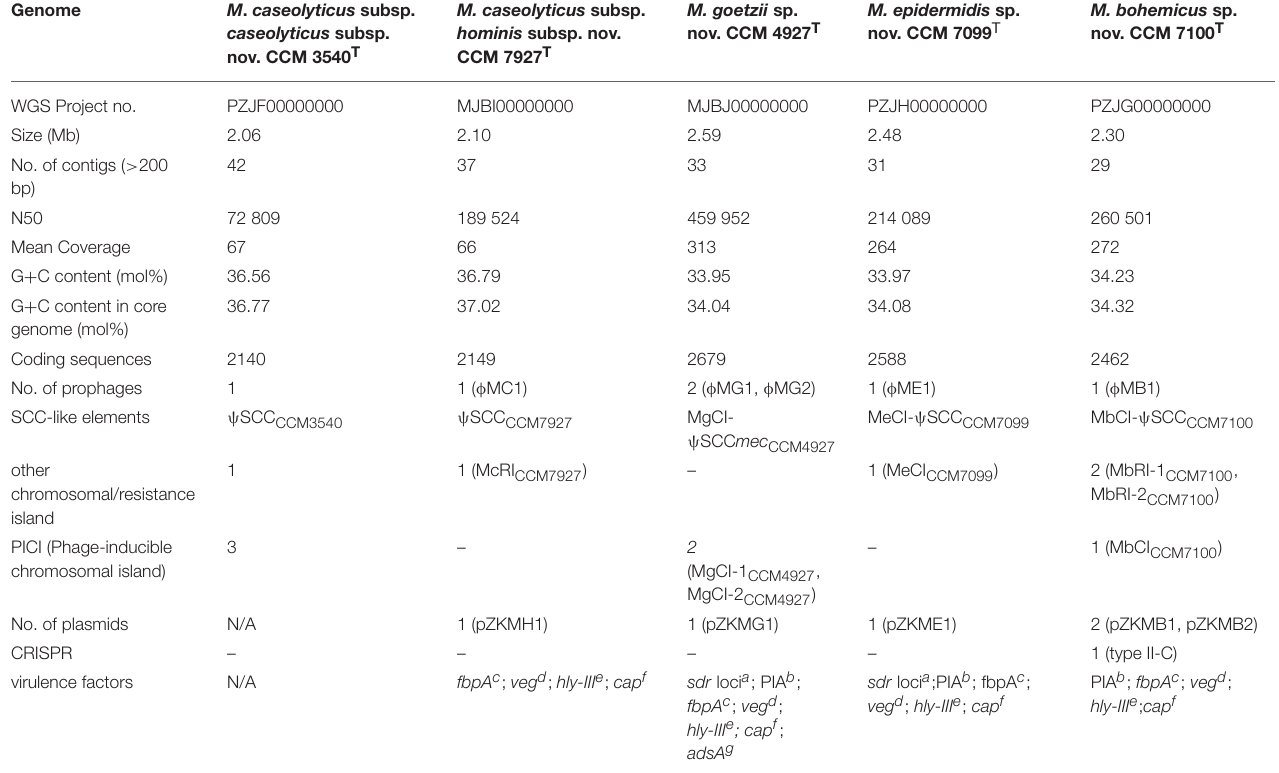
TABLE 2 | Summary of whole genome sequence characteristics of analyzed Macrococcus spp. Genome M . caseolyticus subsp. caseolyticus